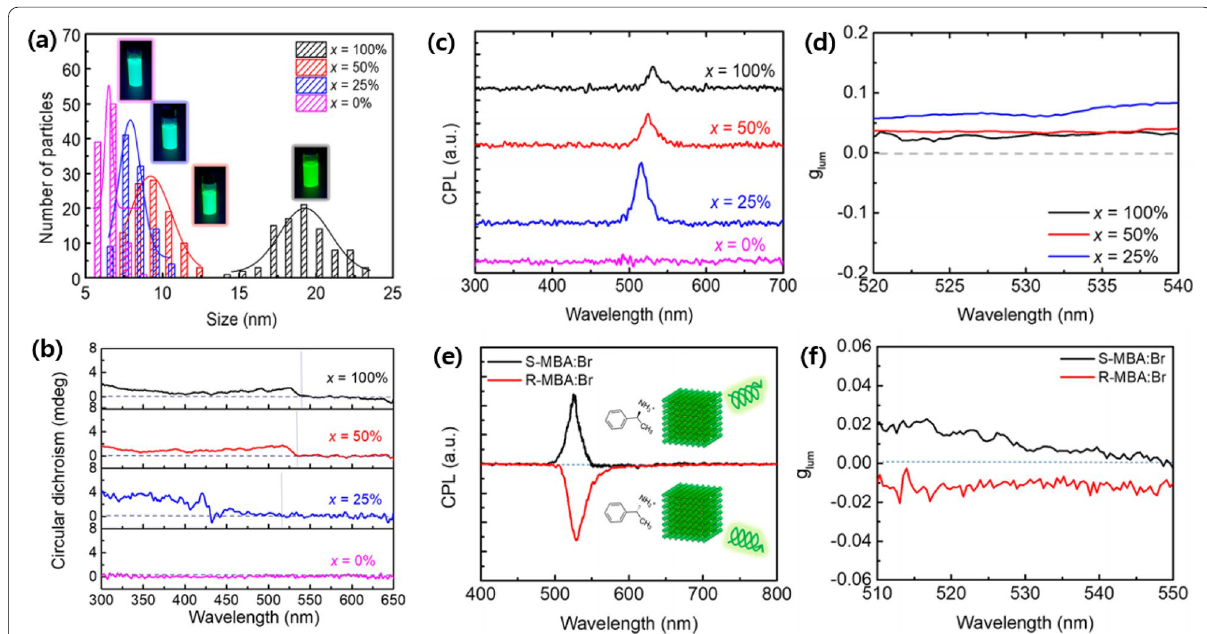
Fig. 12 a Size distribution histograms and photographs under a λ 350 Xe lamp (inset), b circular dichroism (CD) spectrum, c CPP, and d average = glum values measured at 520 λ 540 nm of FAPbBr 3 NP dispersion with different ( R )-2-octylamine concentration x , e CPP and f average glum of ≤ ≤ ligand-treated FAPbBr 3 NPs with R -, S -, MBA:Br. Reproduced with permission from [82]. Copyright American Chemical Society,